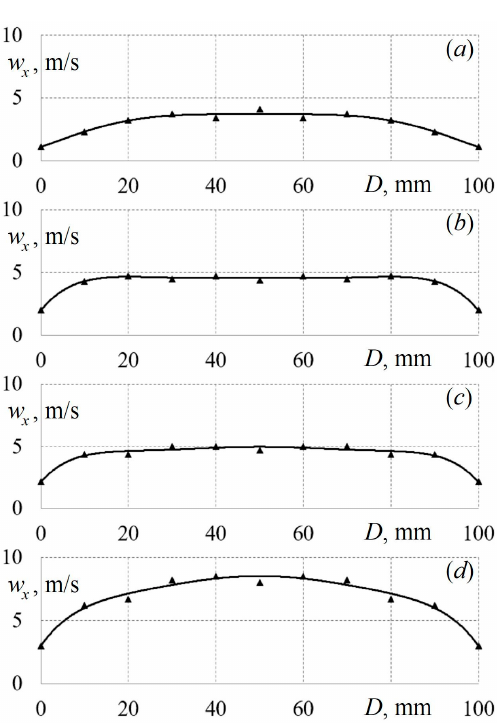
Figure 6. Change in local values of the flow velocity w x along the cylinder diameter D when air is supplied to the diffuser through square tubes for the initial average flow velocity in the first section w 1 ≈ 6.45 m/s along the set-up height: ( a )— H 4 = 800 mm; ( b )— H 3 = 500 mm; ( c )— H 2 = 300 mm; ( d )— H 1 = 100 mm.